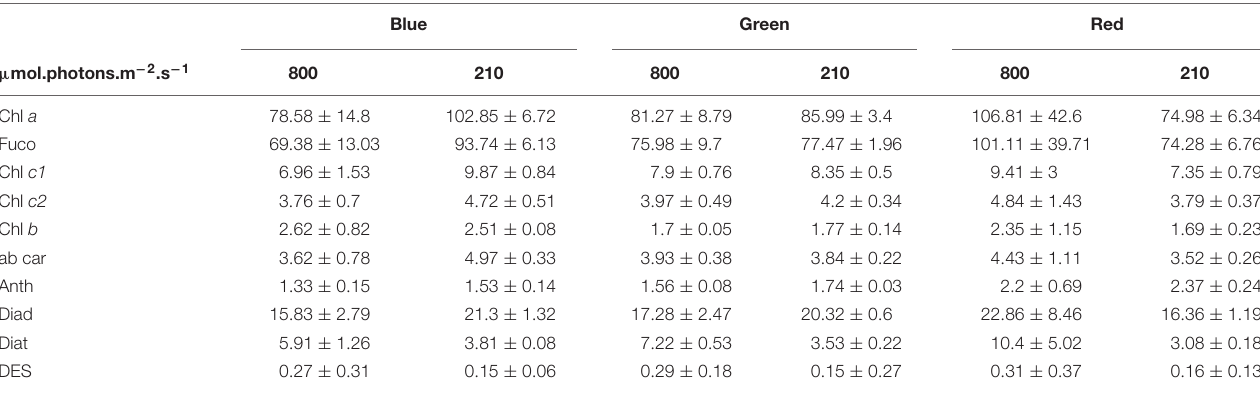
TABLE 3 | Main pigment concentration in ug.g − 1 for migrational